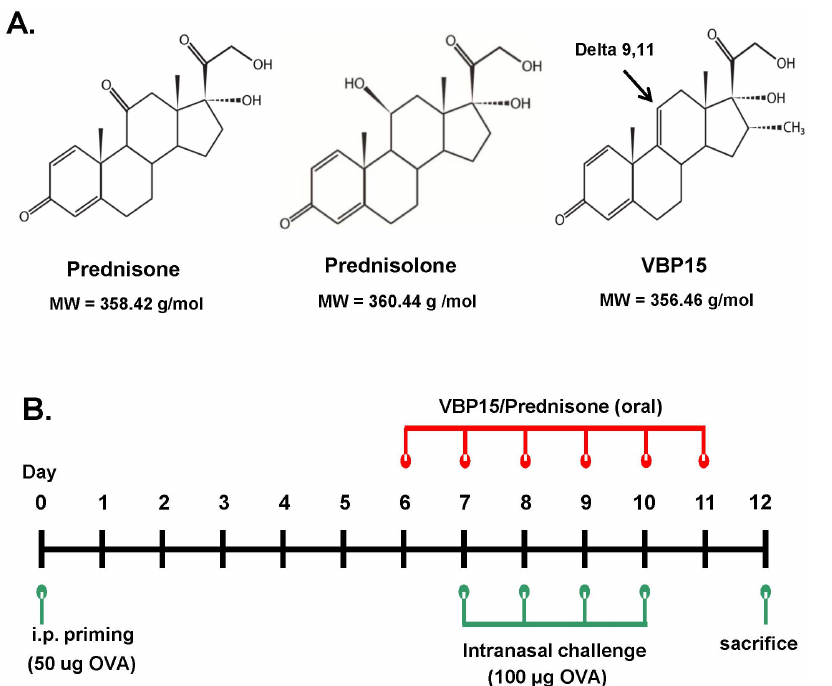
Figure 1. Structure of VBP15 and schematic of the OVA-induced model of acute allergic lung inflammation. (A) Chemical structures of prednisone (left panel), prednisolone (mid panel), and VBP15 (right panel). VBP compounds include a delta-9,11 double bond and tail group modifications. (B) Diagram of OVA-induced mouse model of allergic lung inflammation.